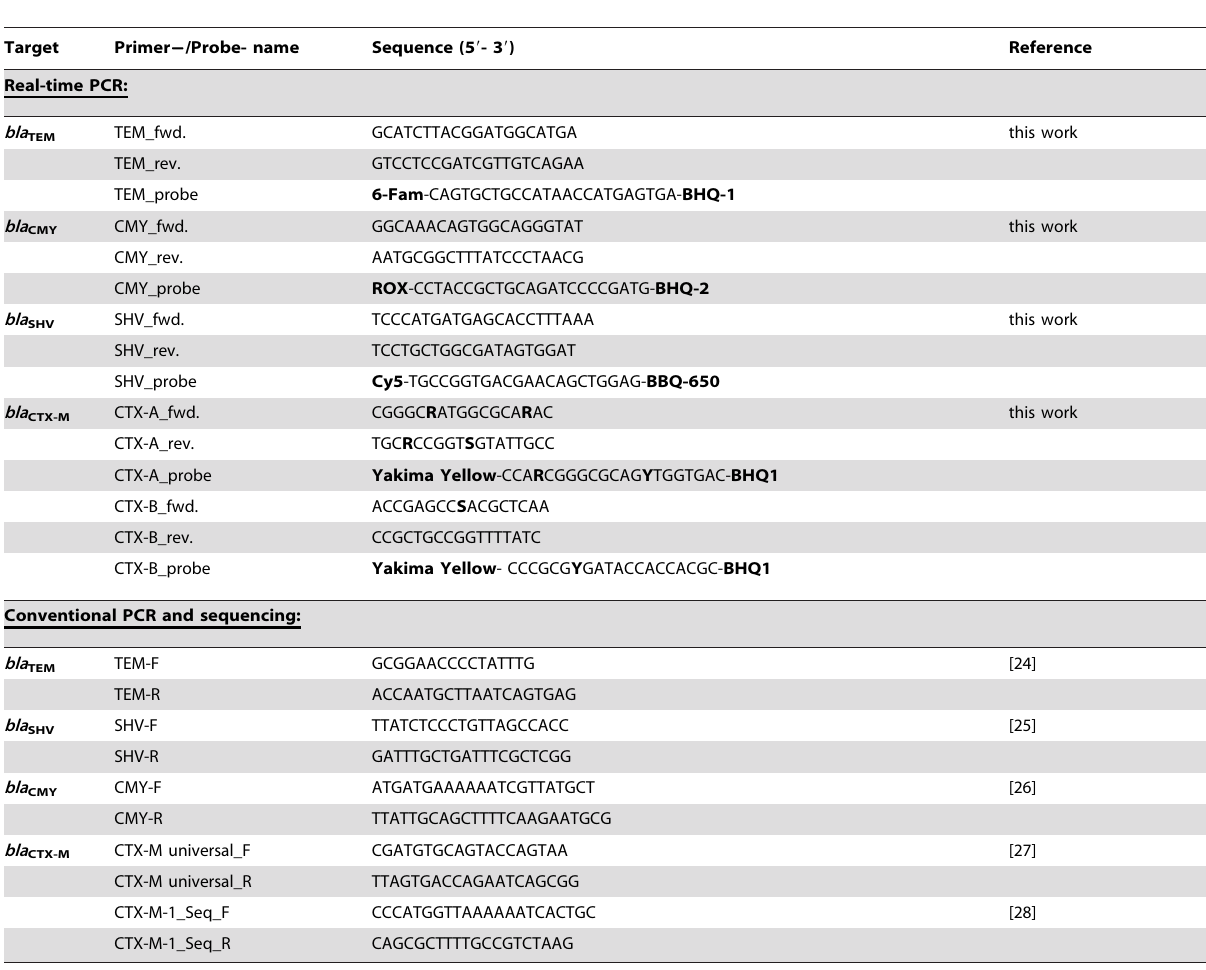
Table 2. Primers and probes used in this